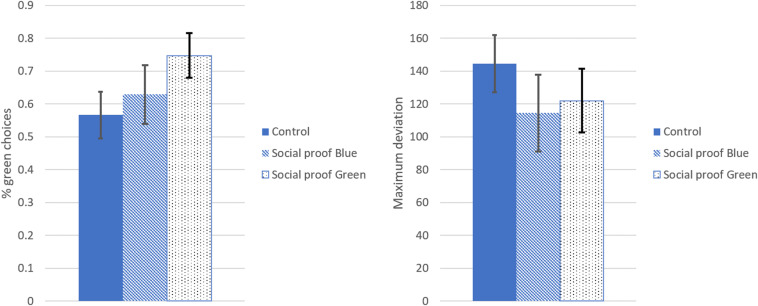
Results Study 1.